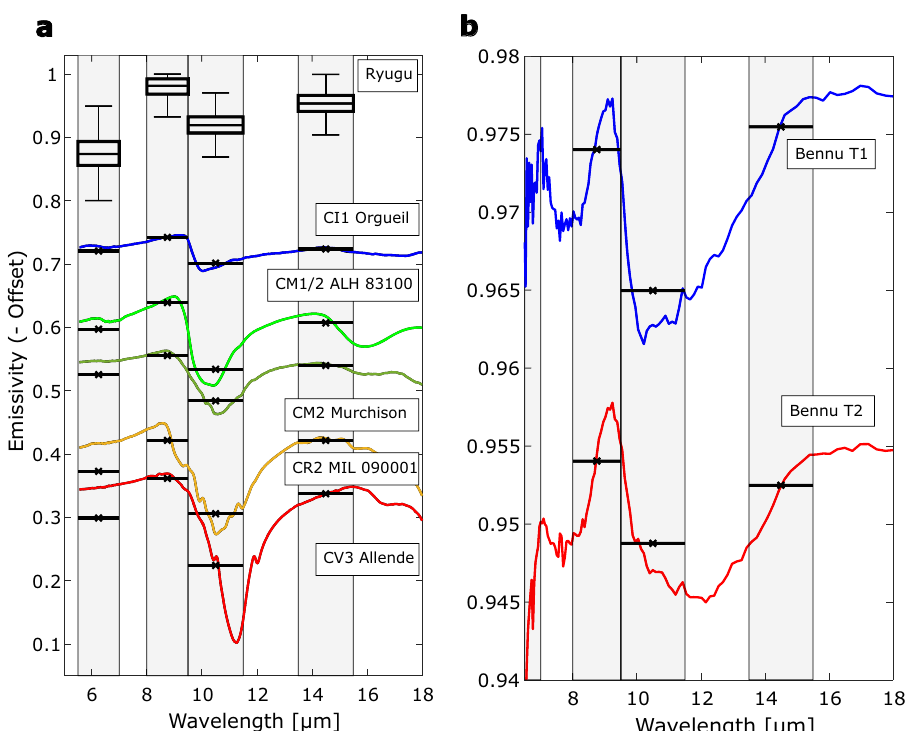
Fig. 5 Comparison of derived emissivity of Ryugu compared to inverted re fl ectance spectra of thin sections of carbonaceous chondrites and OTES emissivity spectra of Bennu. a Boxplot of the posterior distribution of the emissivity within each of the four narrow-band channels compared to spectra of examples of thin-section carbonaceous chondrites 44 , where horizontal lines denote the spectra averaged within the MARA channel and weighted by the instrument function. Re fl ectance spectra are converted to emissivity by subtracting the re fl ectance from 1, and shifted by a constant offset for clarity. The box boundaries are given by the 25th and 75th percentile, the centre is de fi ned by the median, the error bars indicate the range of outliers within 1.5 times the interquartile range from the 25th and 75th percentile, respectively. All thin sections show an emissivity drop in the 9.5 – 11.5 µ m band and the general trend of increasing emissivity from the 5.5 – 7 µ m band to the 8 – 9.5 µ m band and from the 9.5 – 11.5 µ m to the 13.5 – 15.5 µ m band, yet the relative depth of the bands vary systematically. The colours of the spectra were chosen to match the corresponding symbols in Fig. 4. b Emissivity spectra of Bennu 44 along with corresponding averages in the MARA channels. Emissivity in the 5.5 – 7 µ m is not averaged due to measurement artefacts within that wavelength range. The T1 spectrum is shown as measured, the T2 spectrum is shifted by 0.02. Source data are provided as a Source Data fi